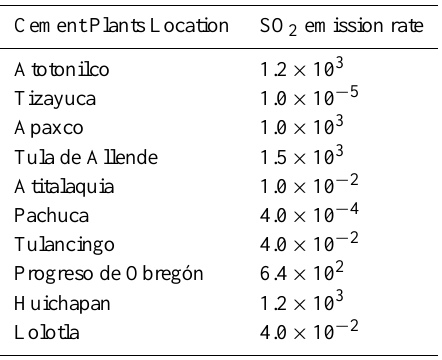
Table 1. SO 2 emission rates for the cement plants used in this study. Units are in kgh − 1